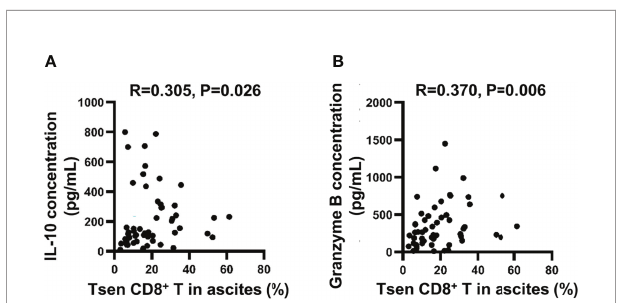
FIGURE 5 | The correlation between ascitic cytokines and the percentage of Tsen CD8 + T cells. Correlation between (A) IL-10 or (B) granzyme B concentration and frequency of Tsen CD8 + T cells in ascites (n = 53) were tested using Spearman ’ s rank coef fi